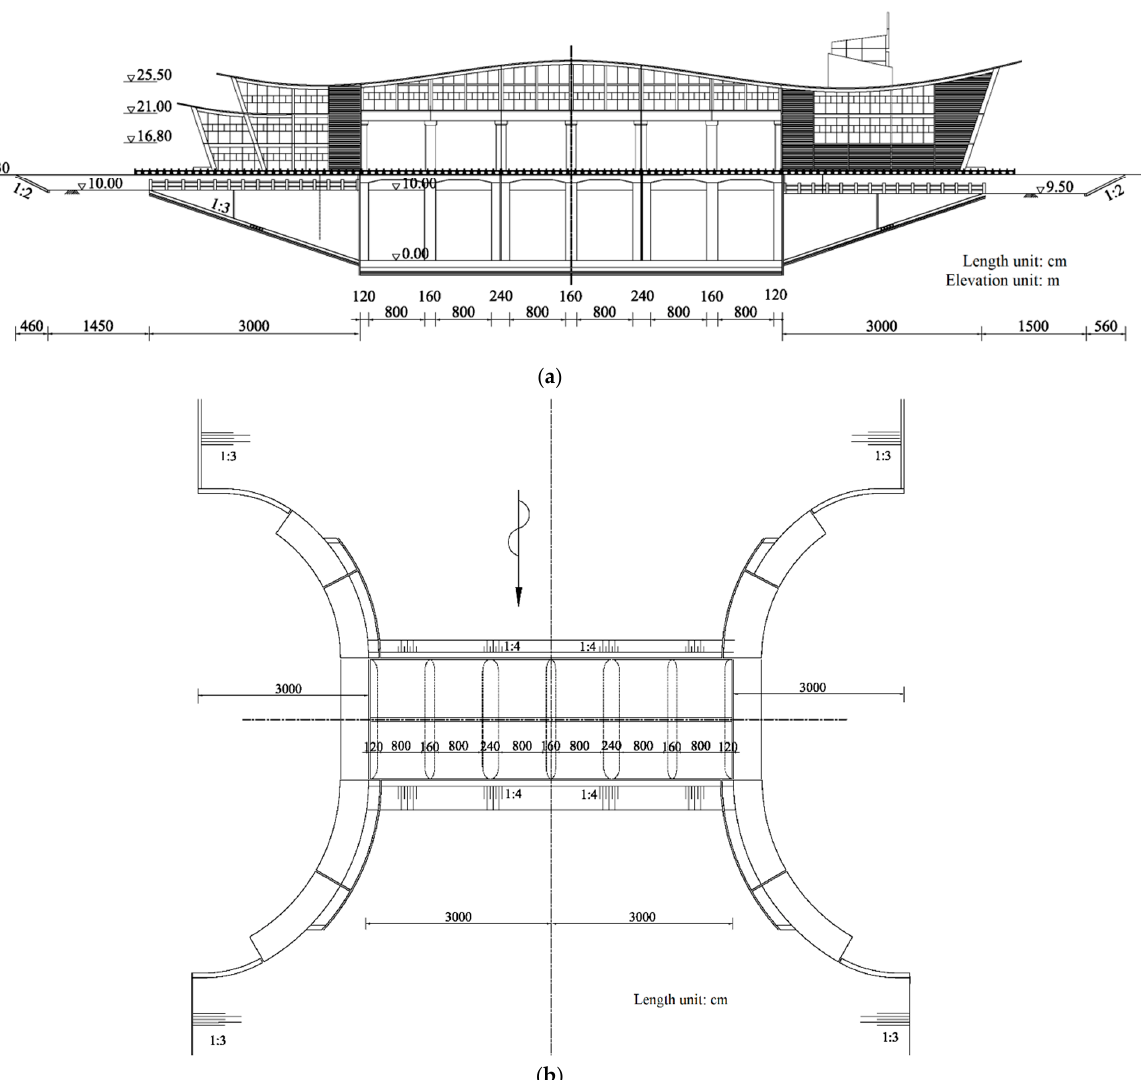
Figure 1. Sluice structure centrally placed in the river course, with six bulkhead gates and connect- ing abutment on each side (looking downstream).